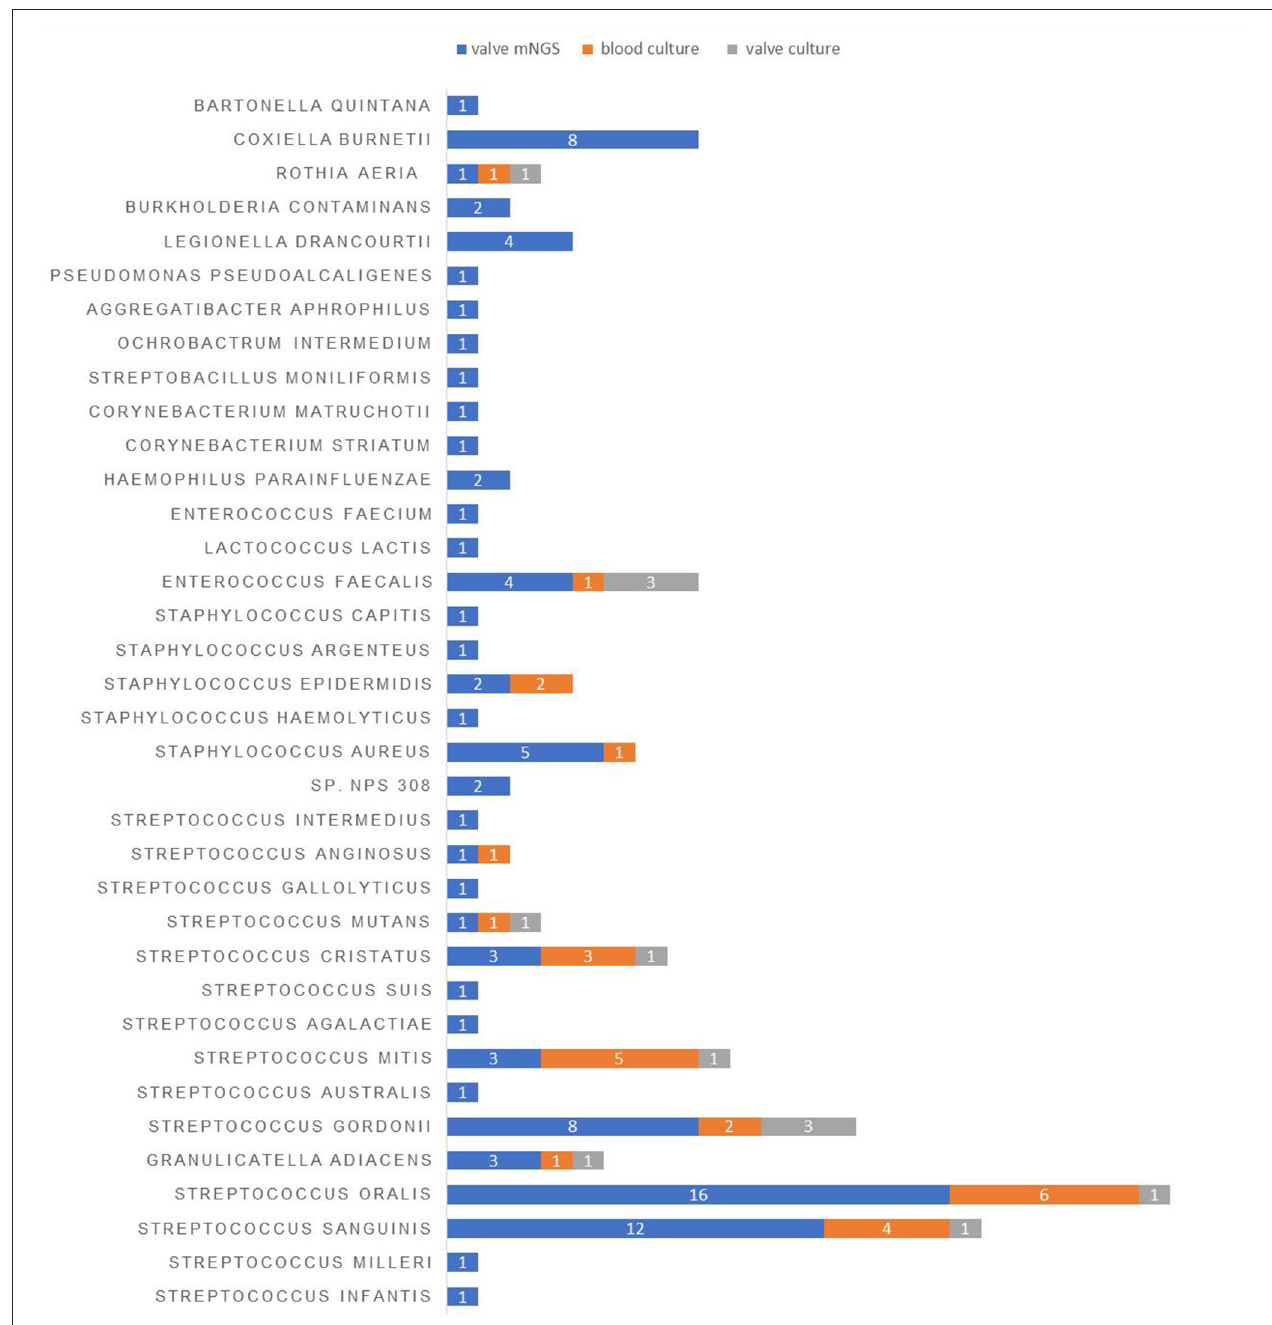
FIGURE 1 | The distribution of pathogens detected in the blood and valve samples of IE patients using different detection methods.